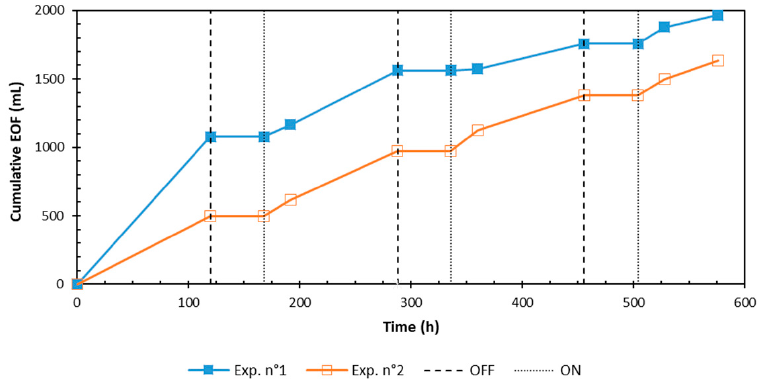
Figure 2. Time evolution of cumulative EOF in the cathode.